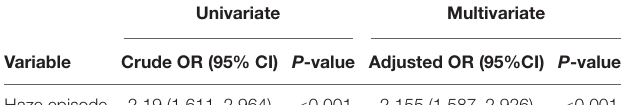
TABLE 5 | Crude and adjusted odds ratios in univariate and multivariate regression analyses (inpatient). Univariate Multivariate